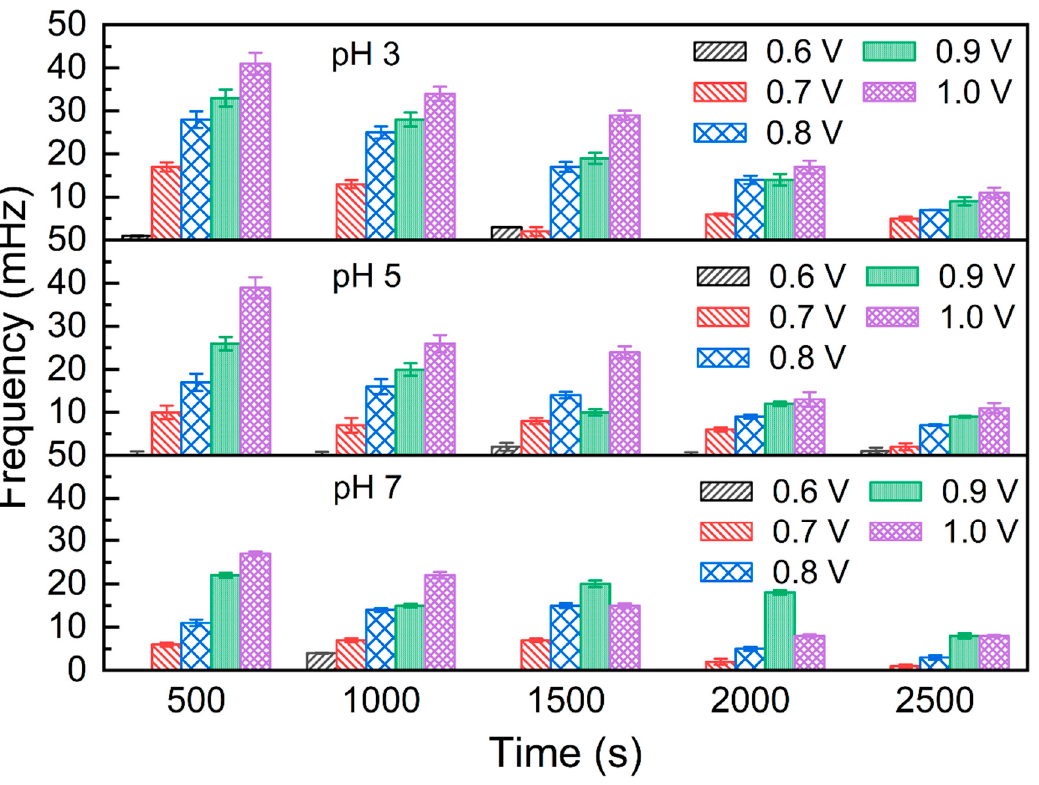
Figure 4. The frequency of pit nucleation for the LPBFed Ti–6Al–4V under the potentials of 0.6, 0.7, 0.8, 0.9, 1.0 V SCE , in Hank’s solution (pH = 3, 5, 7) at 37 °C.